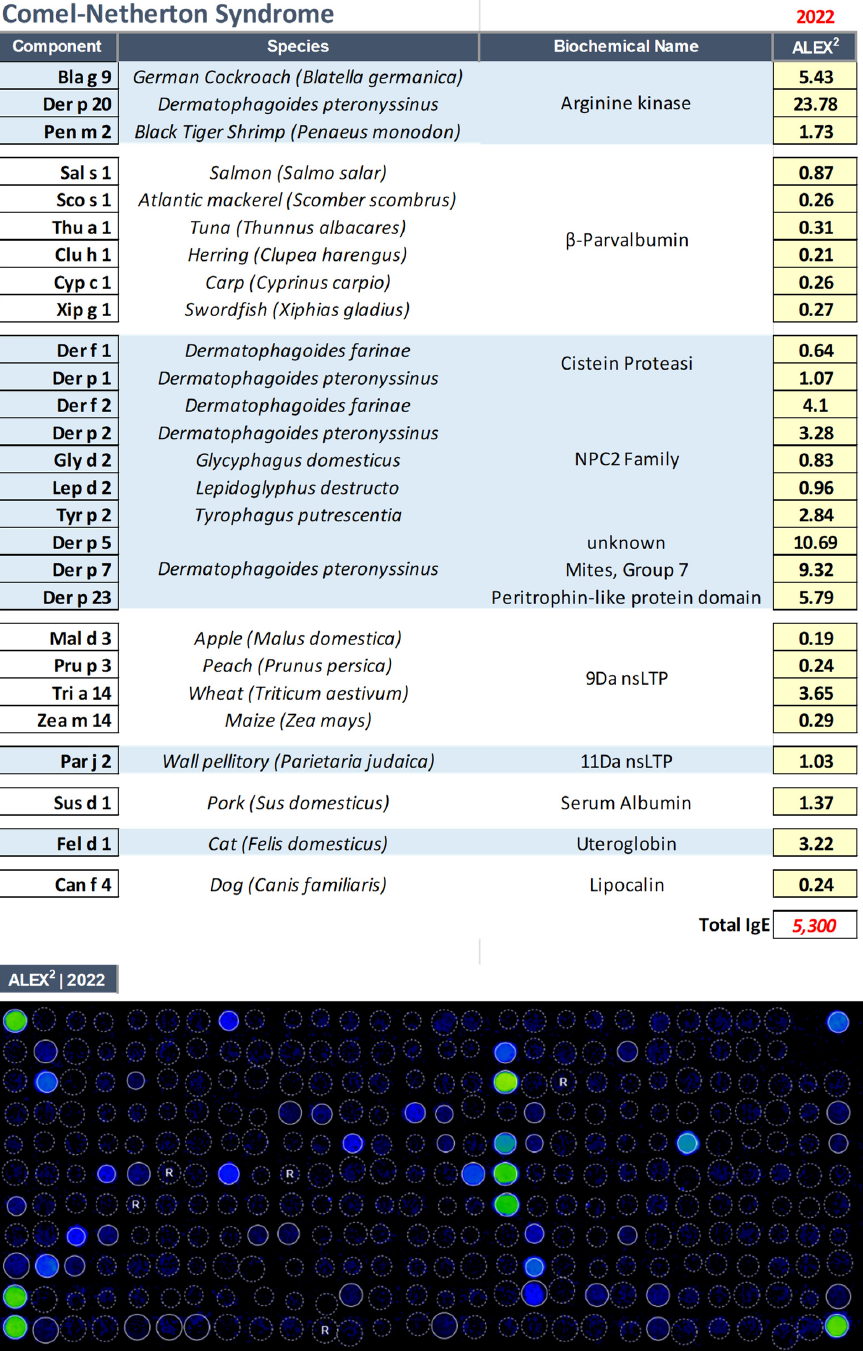
(i.e., heart disease, short stature, brachi– or microcephaly, ear dysplasia, hearing